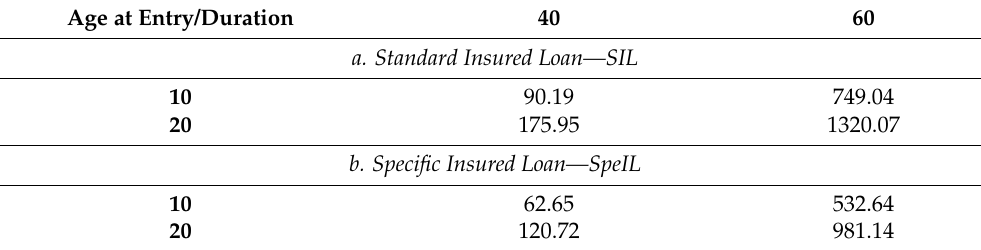
Table 1. Actuarial periodic premium—female. Issue time 2014, r = 2%, i = 7%, C = 200,000.